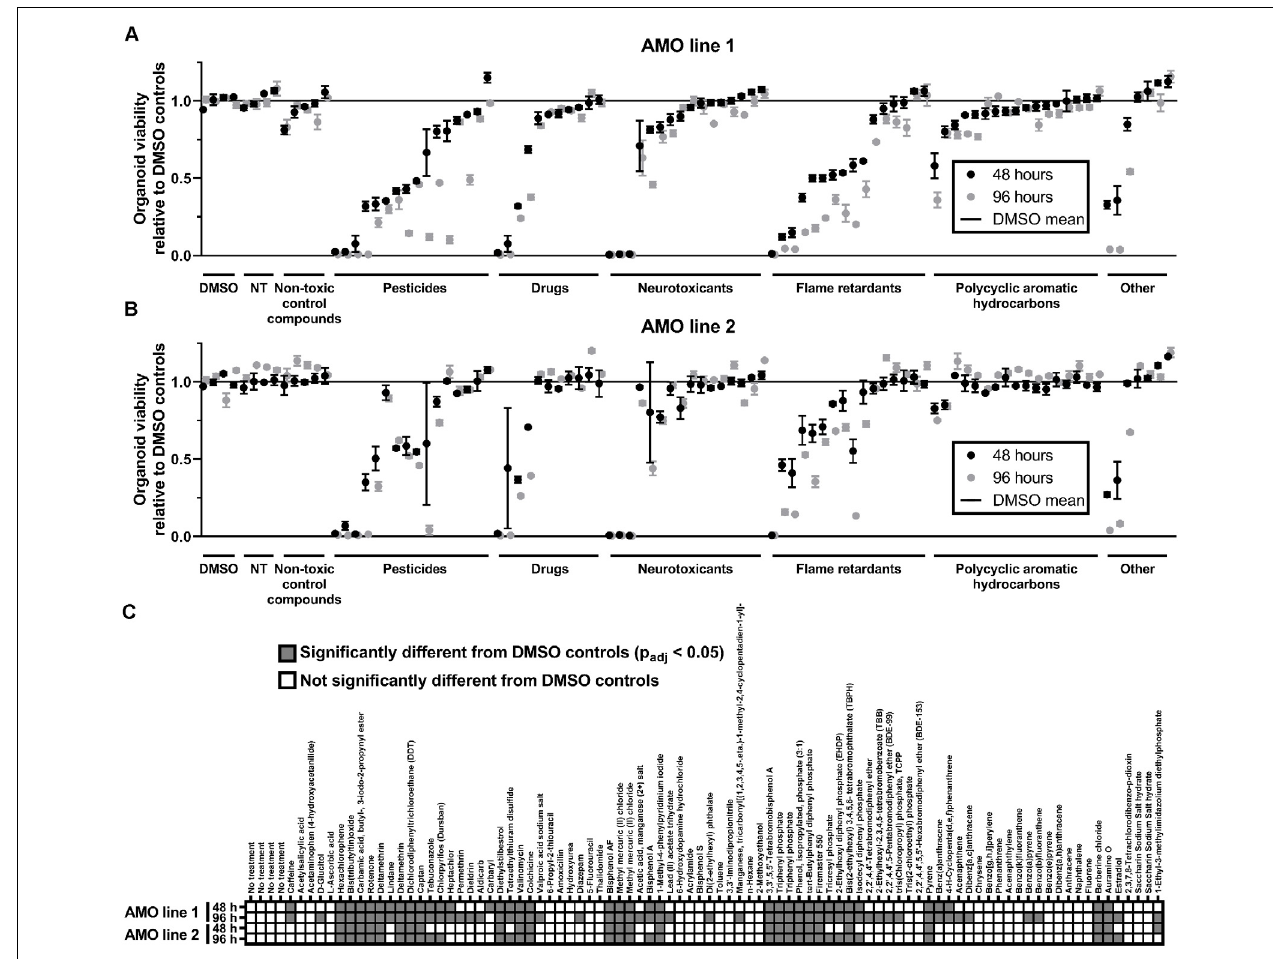
FIGURE 2 | General cell viability identified toxic compounds in an organoid-based high throughput screen. (A,B) While toxicant exposure yields a broad range of organoid viabilities, non-treated (NT) and non-toxic controls cluster around 100% of viability relative to DMSO controls. Dot plots depict the mean viability (relative to the DMSO controls) of organoids in the primary screen after 48 (black dots) and 96 h (gray dots) of compound exposure. Compounds are organized by categories listed below the x-axis, then by the viability of AMO line 1 at 48 h within each category. The order of compounds was maintained for subfigures (A) (AMOs from cell line 1), (B) (AMOs from cell line 2), and (C) (statistical analysis) to facilitate comparison. (C) Combined heatmap for both AMO lines and time points highlights compounds that significantly changed the AMOs’ viability compared to the DMSO controls. Statistical significance was determined via multiple unpaired t -tests,